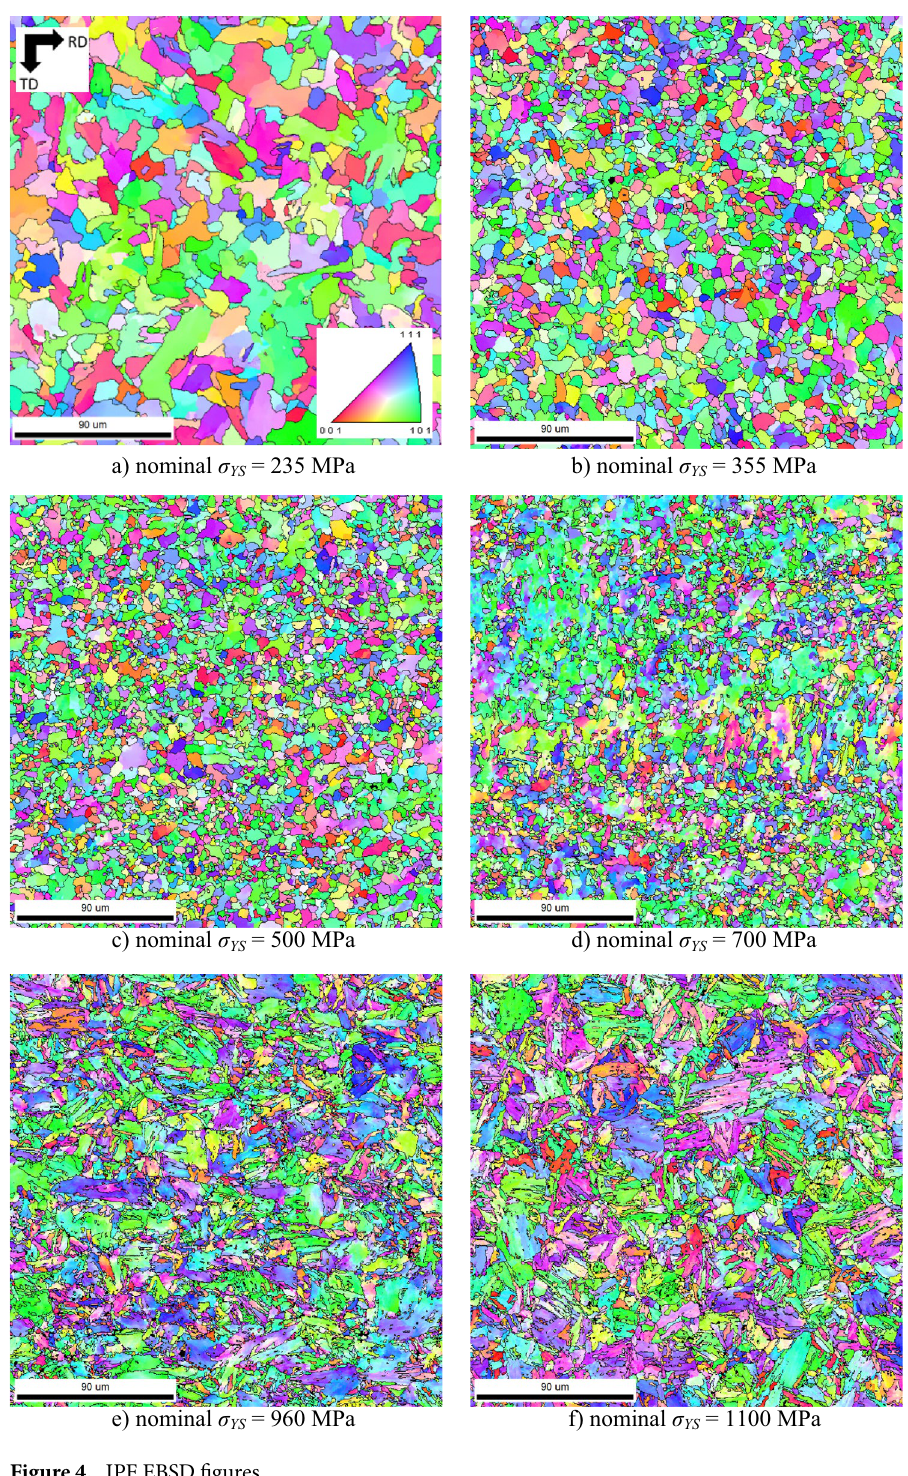
Figure 4. IPF EBSD